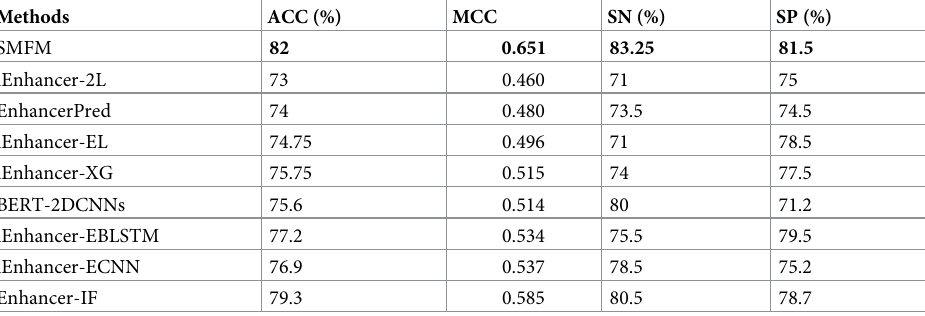
Table 4. Results of each model on the independent test set using four